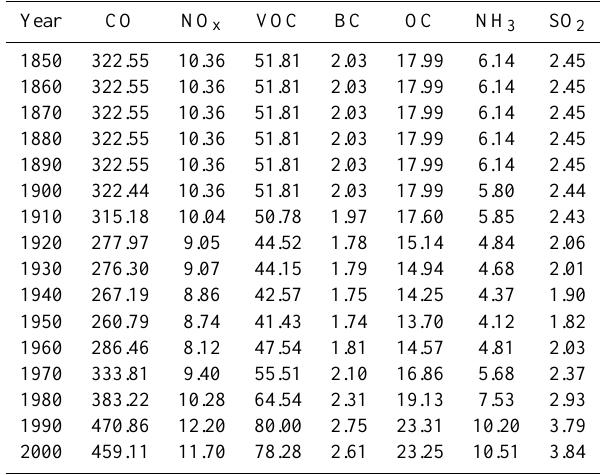
Table 9. Global amounts of emission from biomass burning for each species considered in this study. Tg(species)/year except for NO x which is expressed as